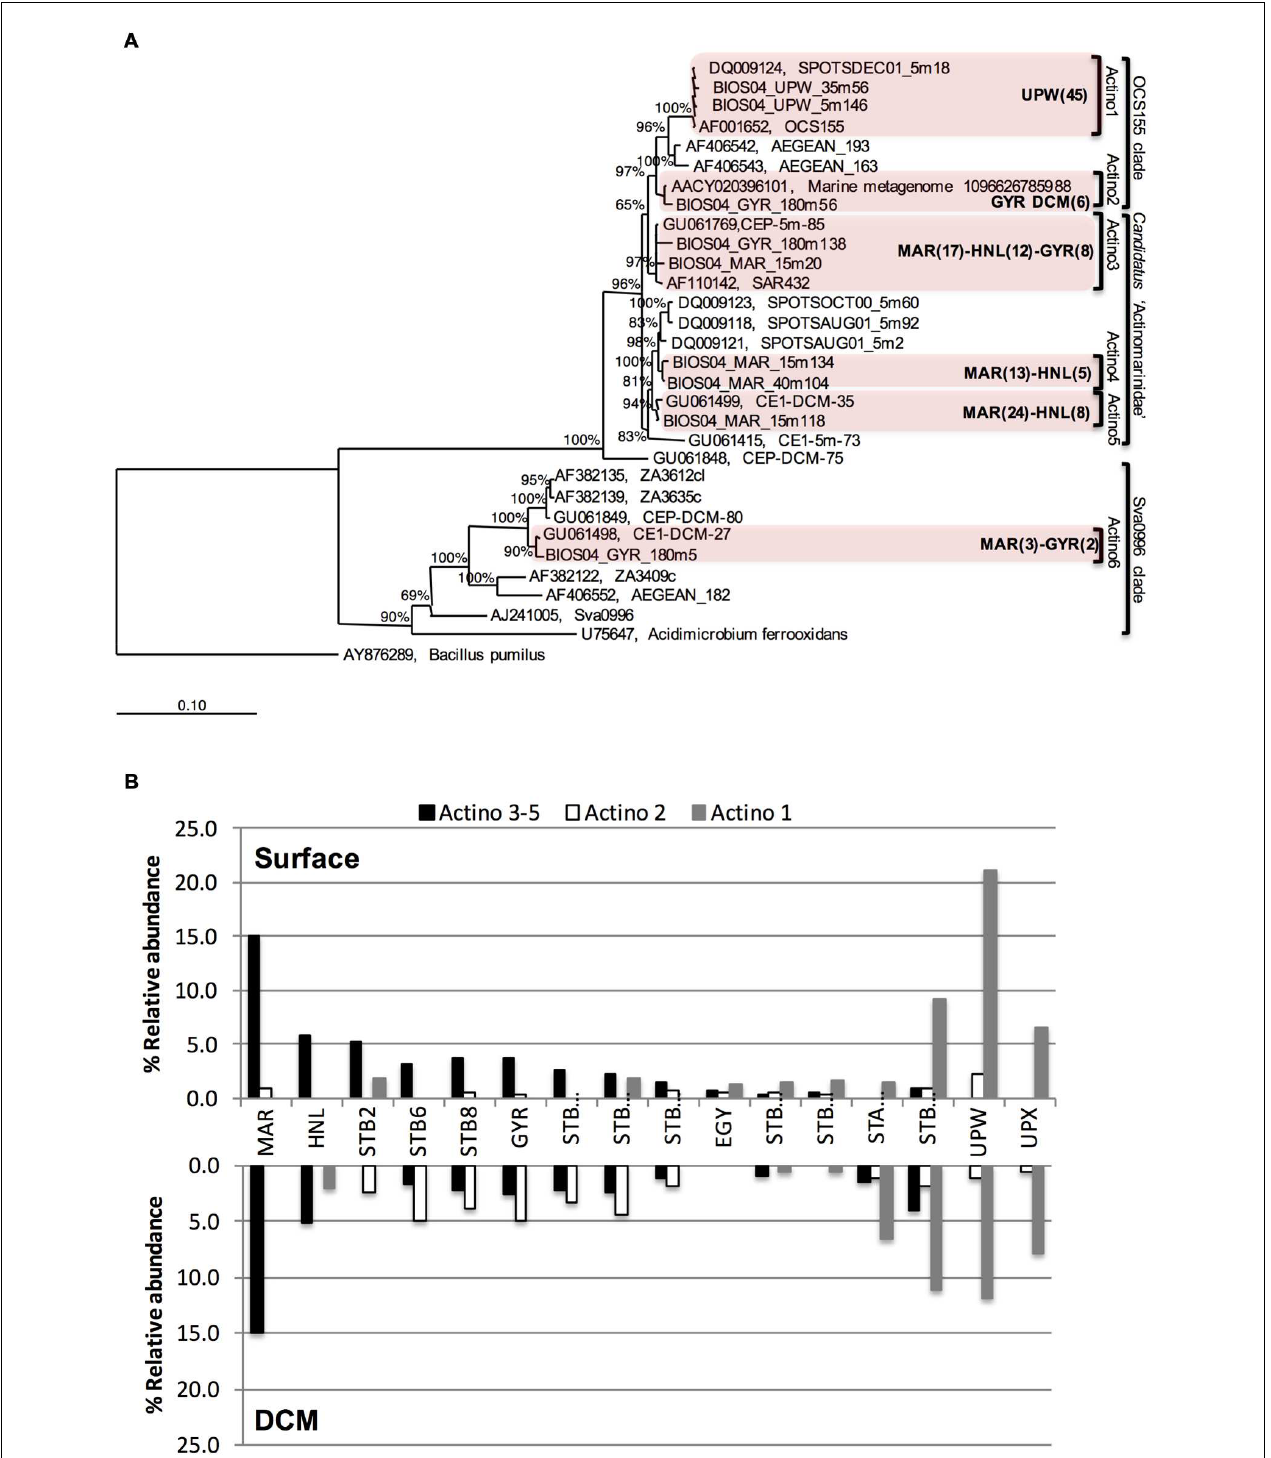
FIGURE 3 | (A) Bayesian-inferred phylogenetic tree of almost full-length Actinobacteria sequences showing the clustering into six different clades depending on their geographical origin. The number of sequences (partial and full-length) attributed to each clade is presented in brackets for a given station. (B) Differential distribution of three assigned Actinobacteria OTUs dominating at MAR and HNL and GYR surface (Actino 3–5), at the GYR DCM (Actino 2), or at UPW (Actino 1) determined from the relative abundance of SSCP peaks from DNA at surface or DCM depths.